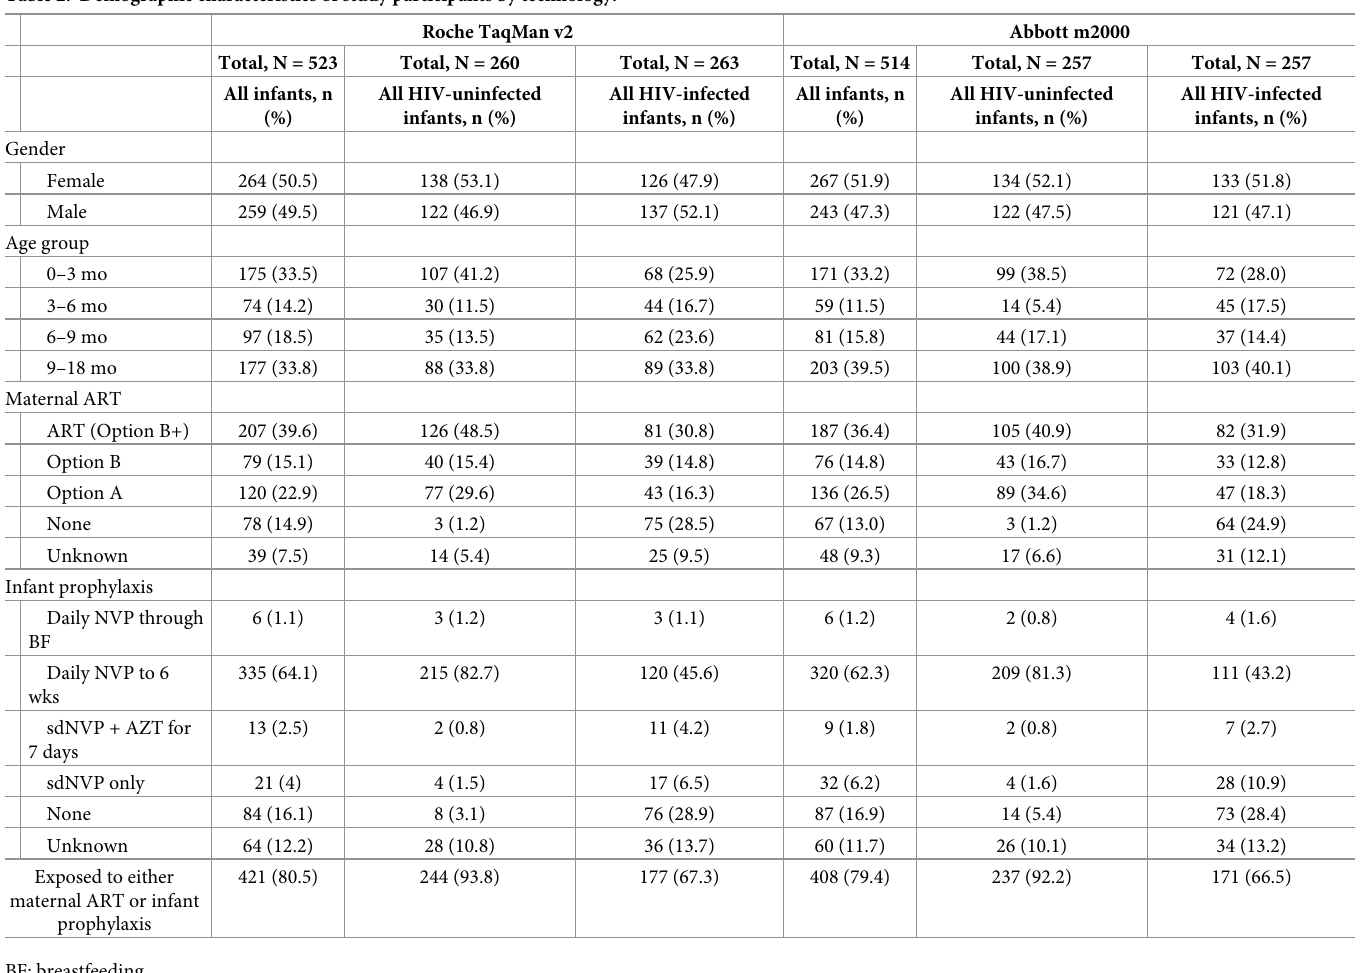
Table 2. Demographic characteristics of study participants by technology.